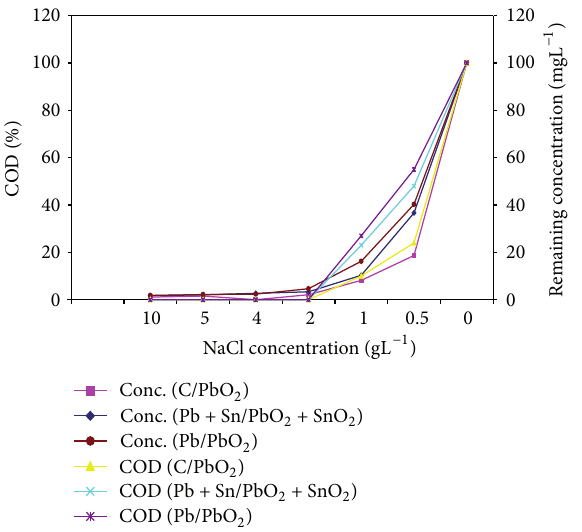
F 3: e effect of current density on RY160 and COD removal using C/PbO